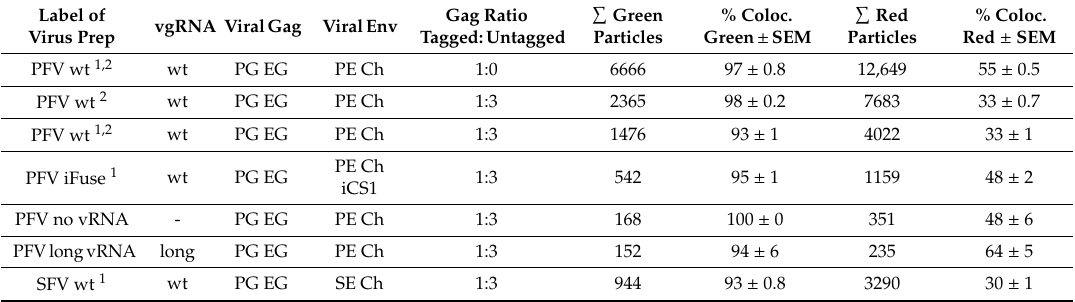
Table 1. Characteristics of dual-color labeled